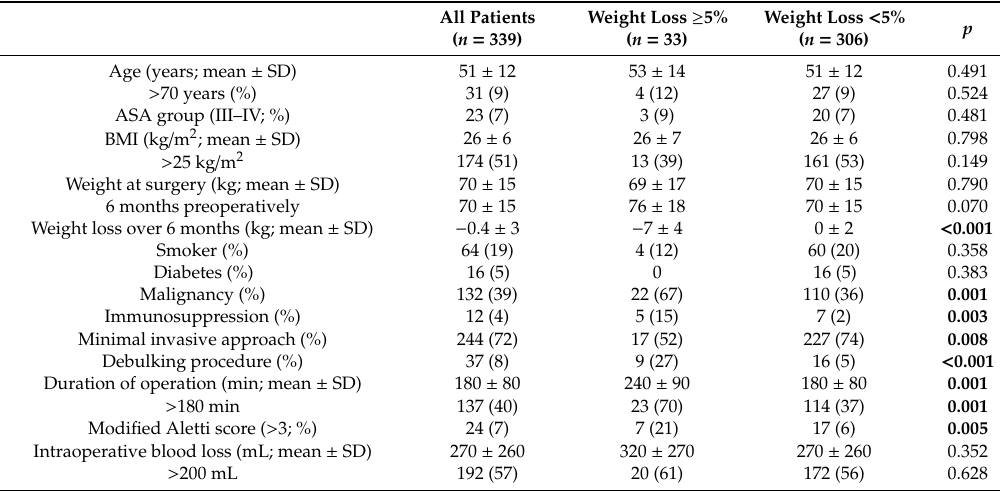
Table 1. Demographics and surgical